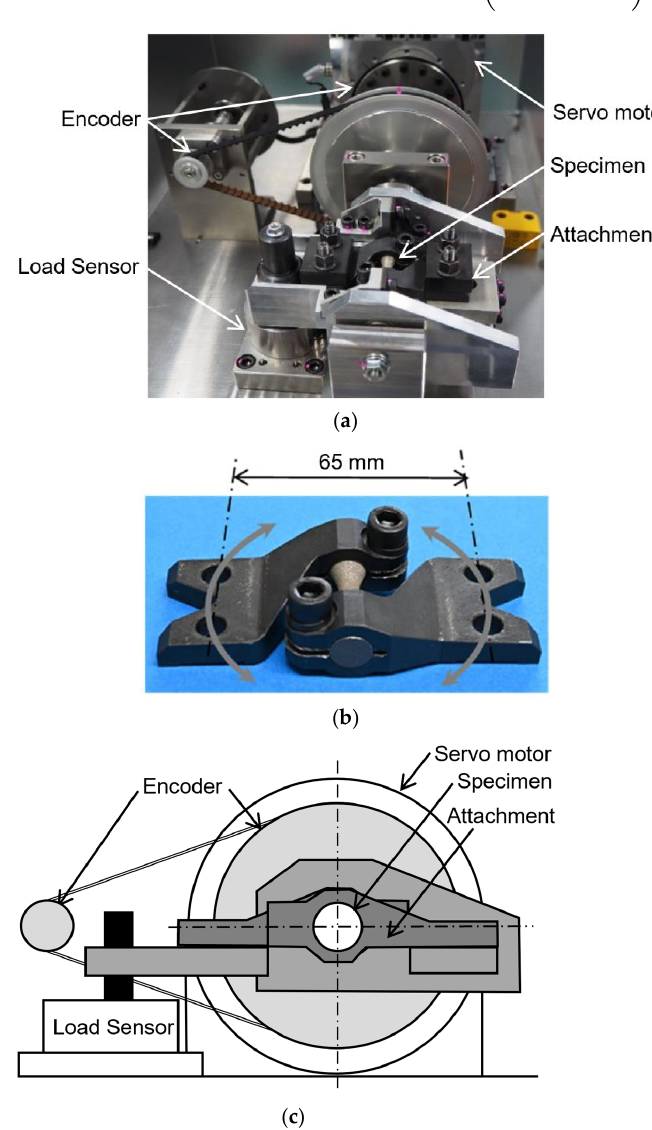
Figure 3. Torsion fatigue testing machine: ( a ) photograph of the machine; ( b ) specimen with attach- ment for torsion fatigue testing; ( c ) schematic diagram of the machine [27].